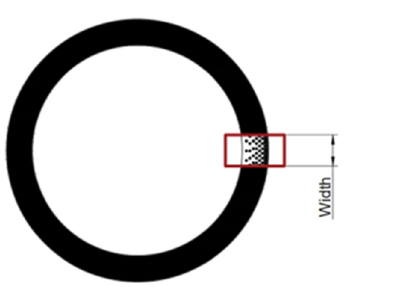
Figure 3. Specimens in the culm for the bending test and microscope observation.